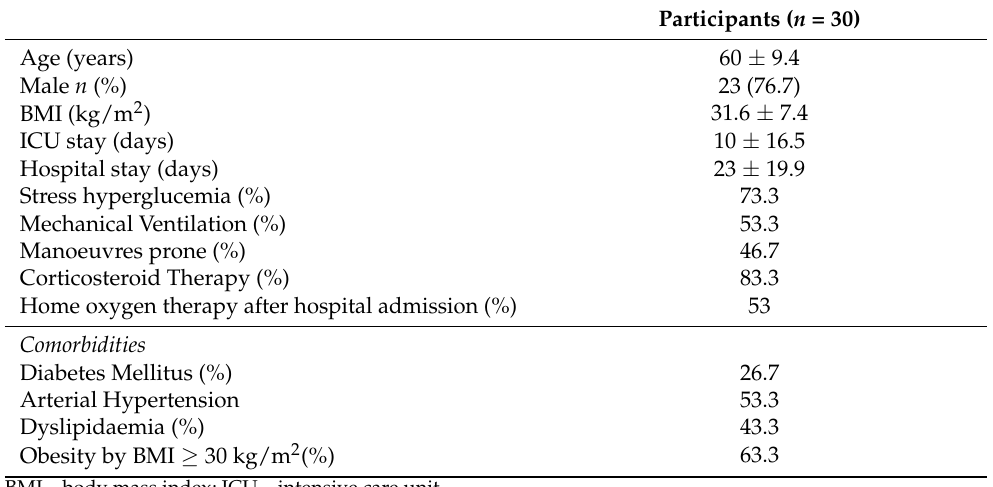
Table 1. Baseline demographic characteristics of post-critical COVID-19